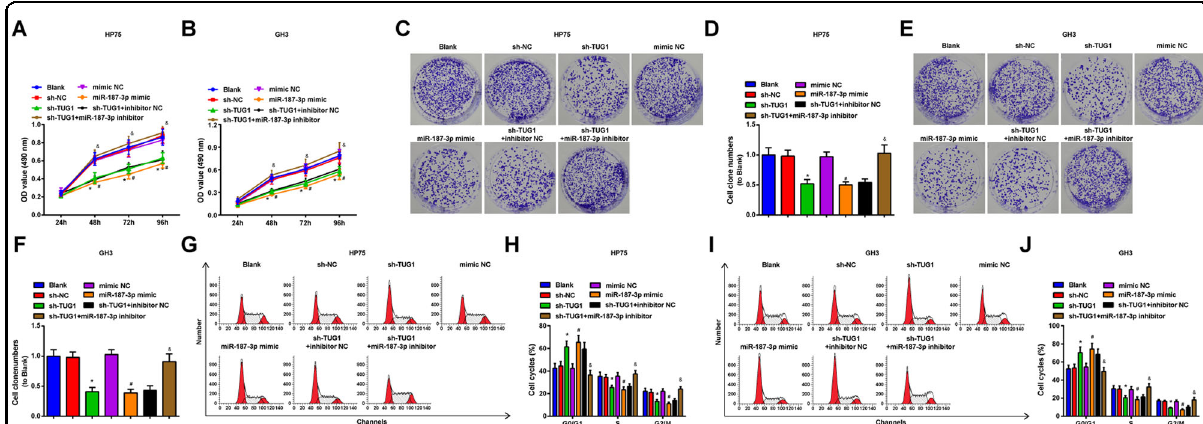
Fig. 3 Inhibited TUG1 or elevated miR-187-3p restrains proliferation and promotes cell cycle progression of PA cells. A viability of HP75 cells was assessed by MTT assay; B viability of GH3 cells was assessed by MTT assay; C colony formation ability of HP75 cells was measured by colony formation assay; D statistical results of colony formation ability of HP75 cells; E colony formation ability of GH3 cells was measured by colony formation assay; F statistical results of colony formation ability of GH3 cells; G cell cycle distribution of HP75 cells was determined by fl ow cytometry; H statistical results of cell cycle distribution of HP75 cells; I cell cycle distribution of GH3 cells was determined by fl ow cytometry; J statistical results of cell cycle distribution of GH3 cells; repetitions = 3. Data are presented as mean ± SD. * P < 0.05 vs the sh-NC group, # P < 0.05 vs the mimic NC group, & P < 0.05 vs the sh-TUG1 + inhibitor NC